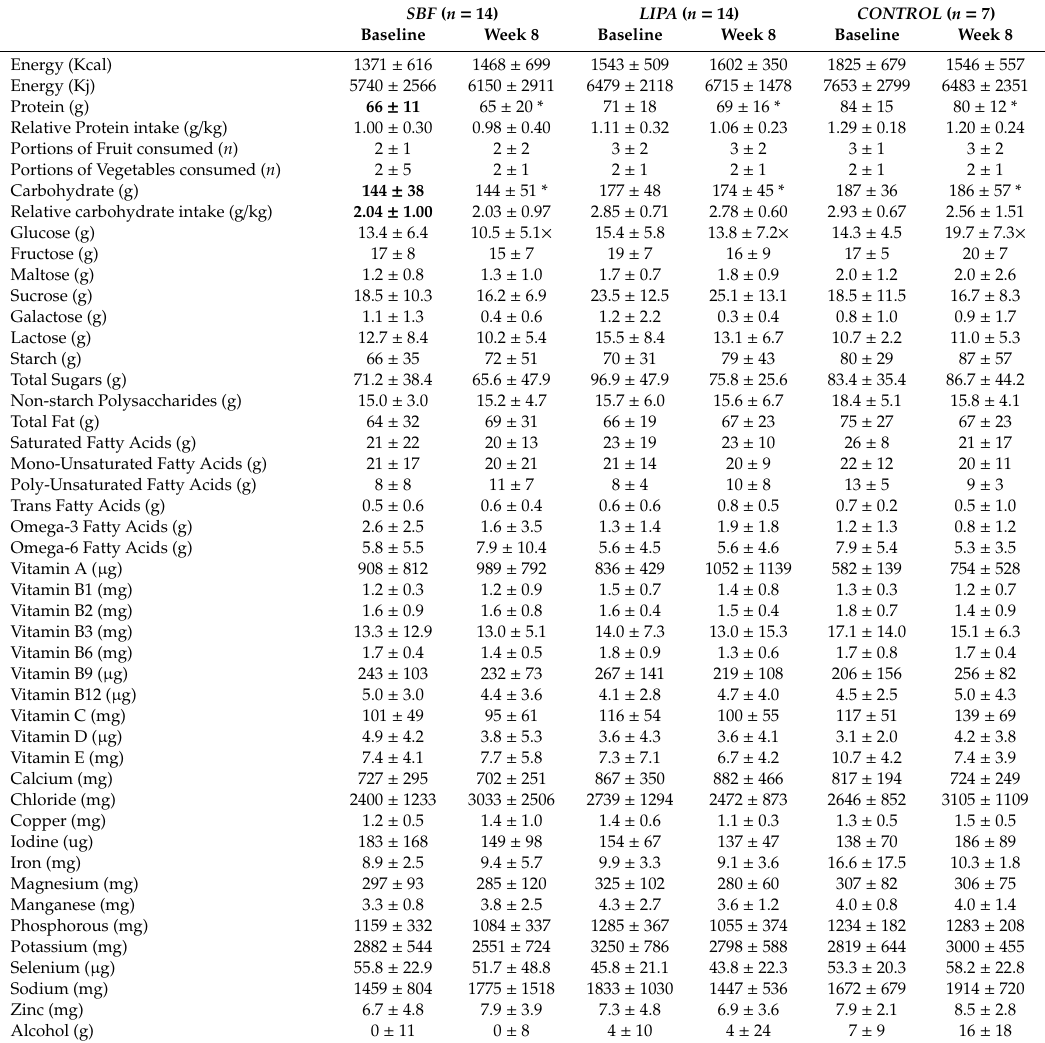
Table 2. Habitual dietary outcomes at baseline, and week 8, for each